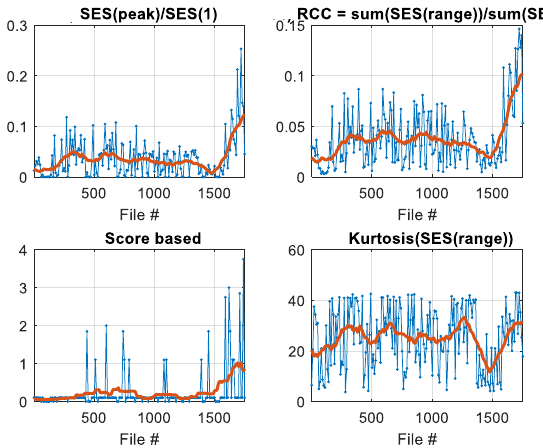
Figure 15. Fault severity indices (part 2), first frequency band—right TB.